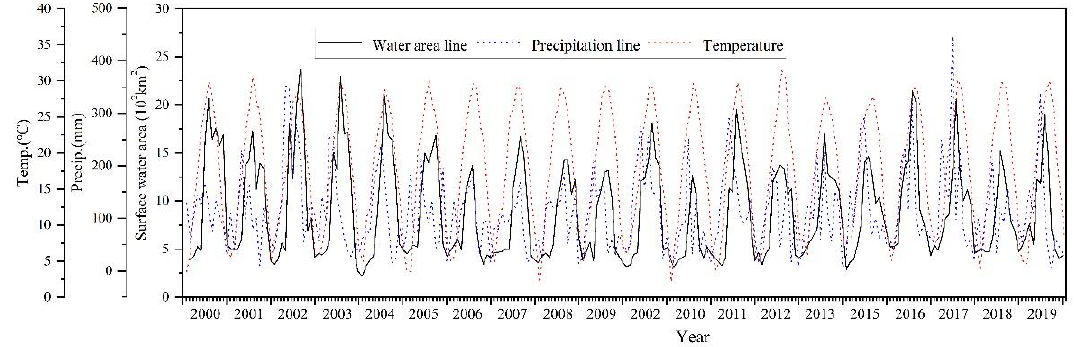
Figure 9. Seasonal changes of surface water, precipitation and temperature from 2000 to 2019.